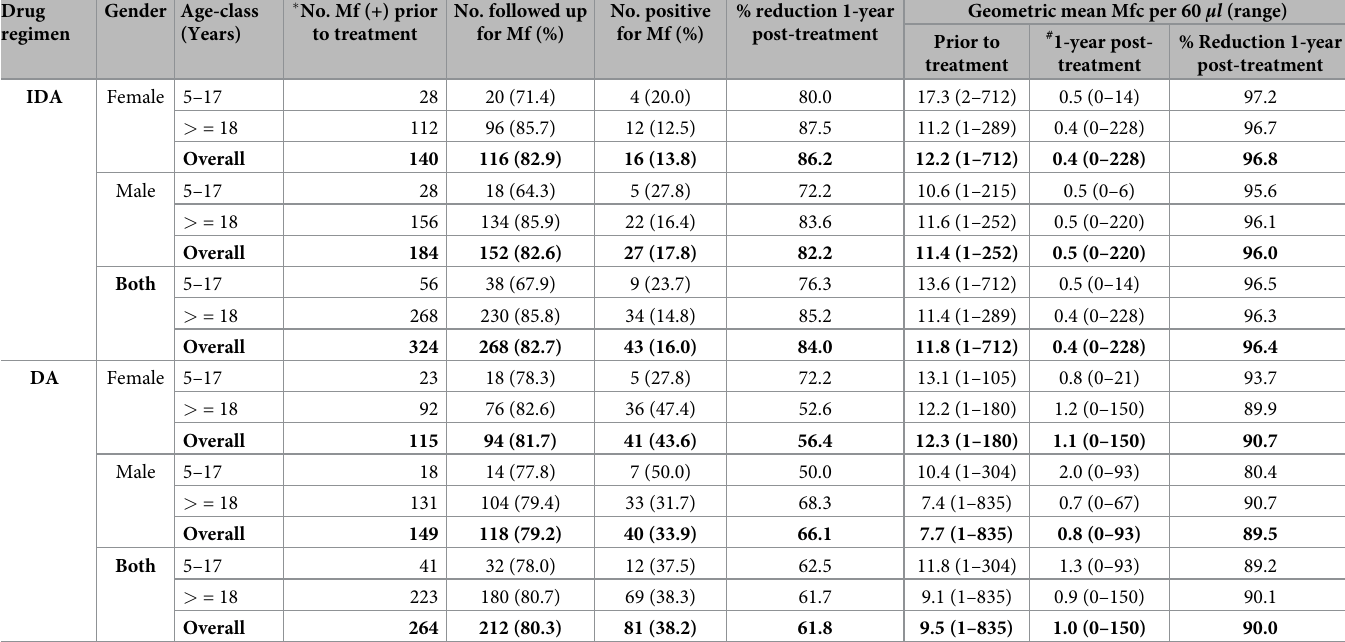
Table 7. Reductions in microfilaria (Mf) positivity and geometric mean Mf-count 1-year post-treatment with IDA or DA. Reduction in Mf-positivity is calculated as % becoming negative for Mf among persons Mf-positive prior to treatment. Drug Gender Age-class regimen (Years)